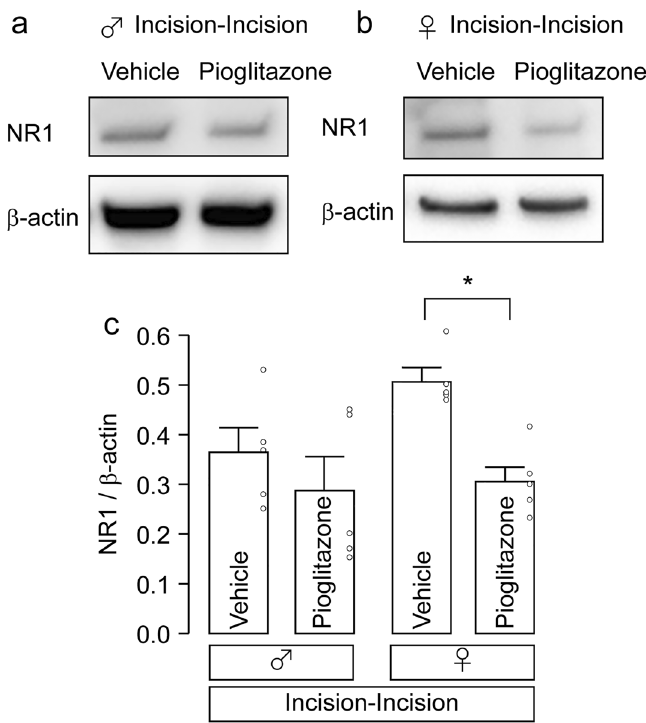
Figure 7. The effects of pioglitazone on NR1 expression in the Vc of incision-incision rats. ( a, b ) Representative blot of NR1 expression in the Vc of male ( a ) and female rats ( b ) 10 days after whisker pad skin re-incision. Original blots are presented in Supplementary Figs. 3 and 4. ( c ) The columns represent the average value of NR1/β-actin. Data represent the mean ± SEM. n = 5 in each, two-way ANOVA post hoc Tukey’s test, * p =